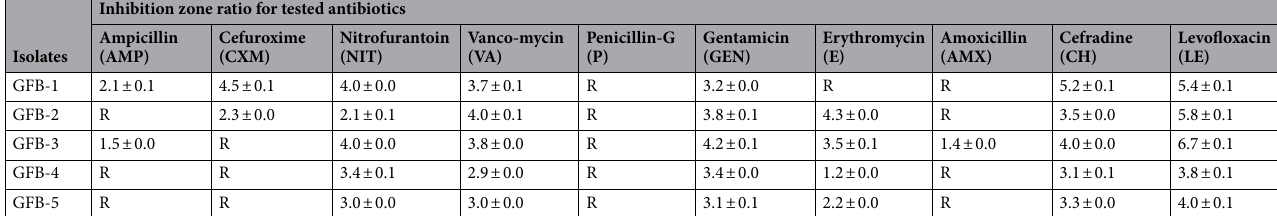
Table 3. Antibiotic susceptibility profile of five bacterial probiotic strains isolated from the gut of B. gonionotus. Ampicillin (25 μg disk −1 ), Cefuroxime (30 μg disk −1 ), Nitrofurantoin (30 μg disk −1 ),